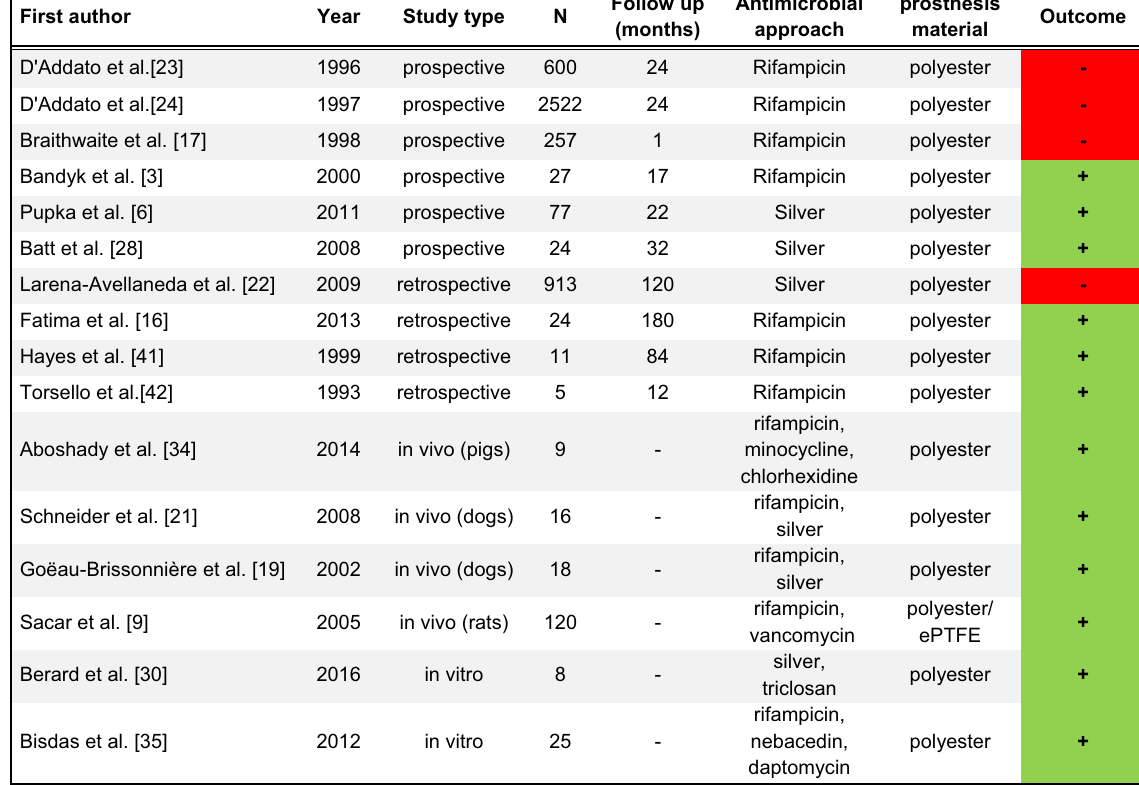
Table 1 Literature overview regarding prospective, retrospective, in vitro and in vivo data on rifampicin and silver-coated vascular